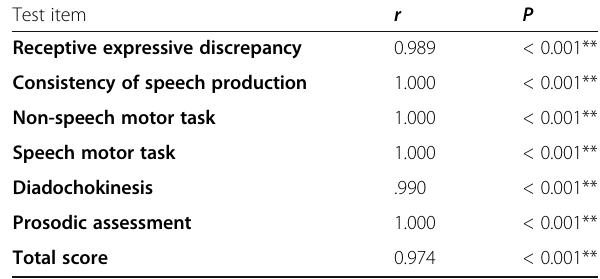
Table 2 Test-retest reliability of individual items of CAS test battery Test item Receptive expressive